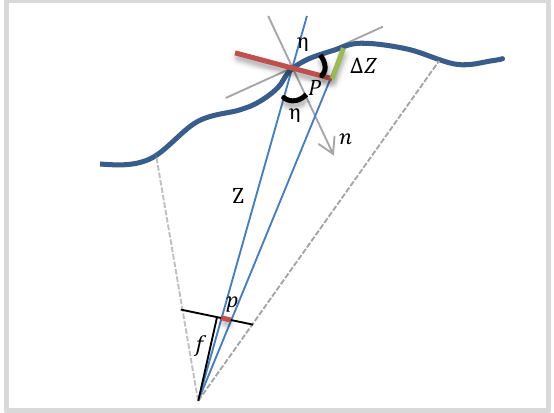
Figure 8: Acquisition of the surface (blue) with a normal vector by a camera with focal length and pixel pitch . The shift in depth between two neighboring pixels leads to a disparity gradient